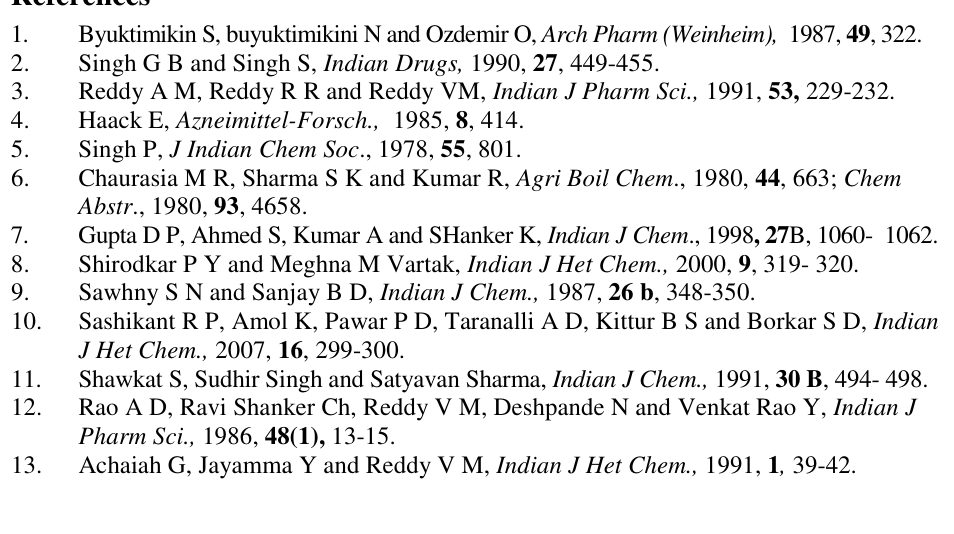
-b , IIIc -c , IIId 1 4 1 4